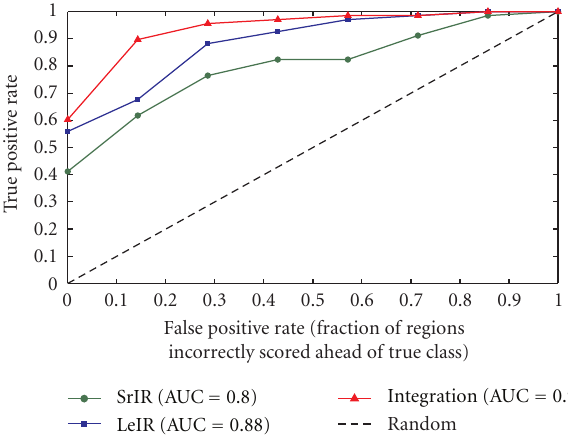
Figure 4: Modified ROC curves to evaluate the overall capability of each data type to predict region versus the integrated